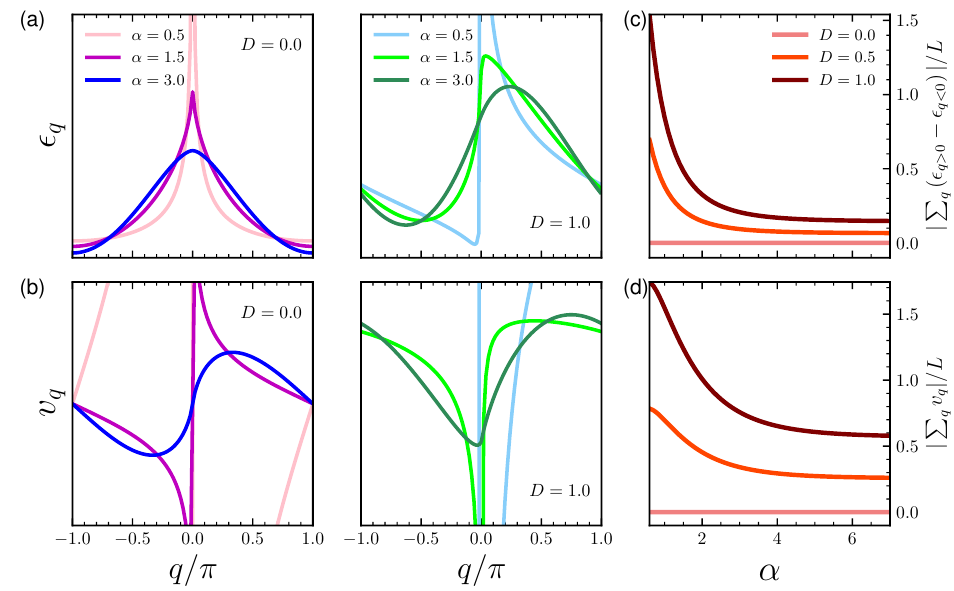
Figure 3: (color online) (a,b) Energy dispersion ε ε = d q v of Eq.(5) for various interactions range. Results of two DM interactions g dq shown on left ( D = 0.0) and middle ( D = 1.0) panels, respectively. (c,d) A figure